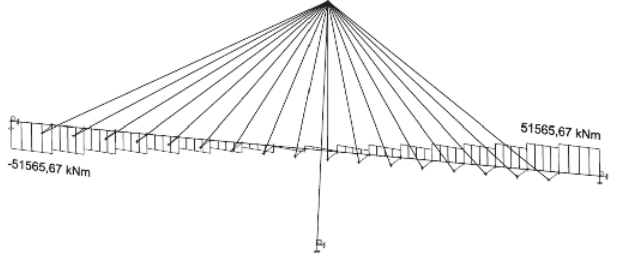
Figure 28 Torsional moment on straight deck (P+L): external case